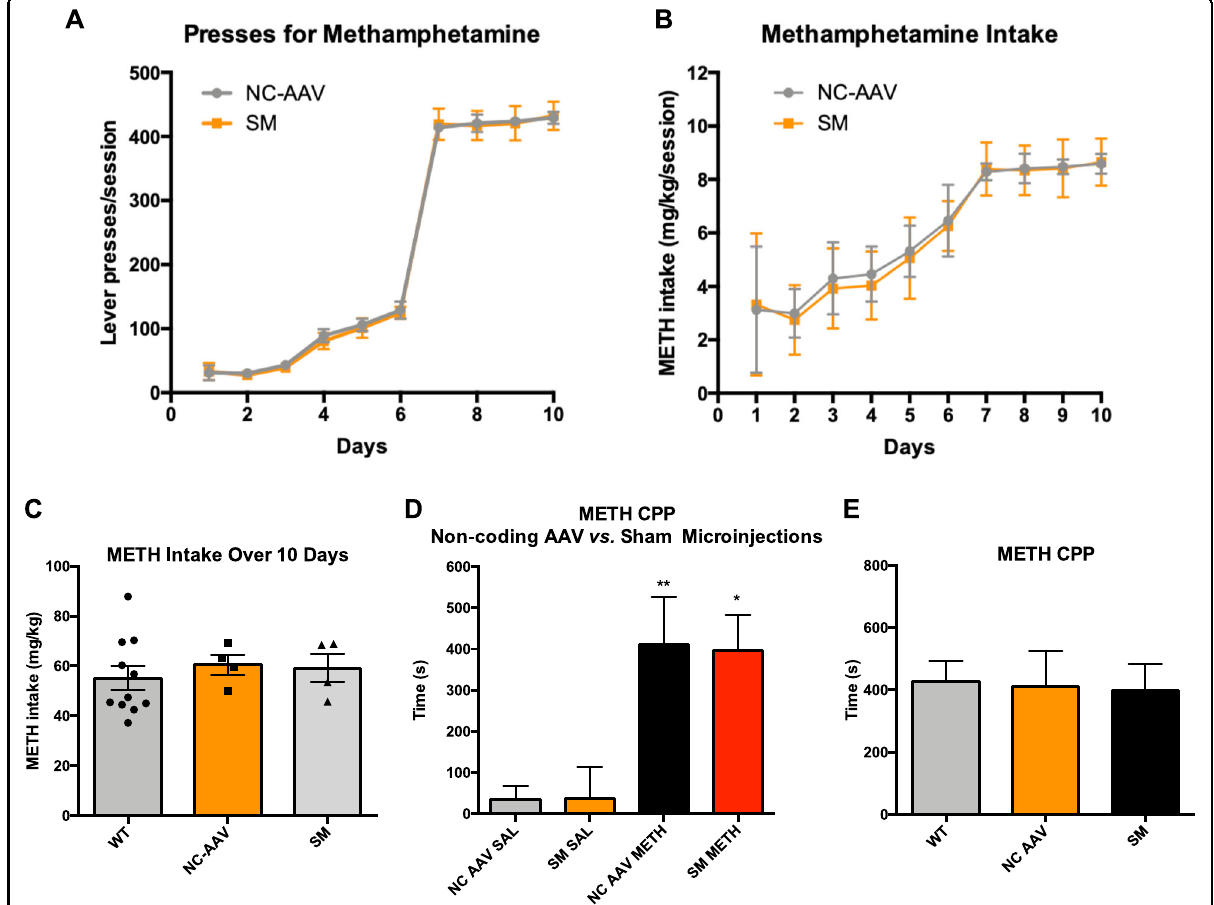
Fig. 2 Noncoding-AAV and Sham-microinjection control for behavioral experiments. Neither noncoding AAV2/6 (NC-AAV) nor sham microinjection (SM, microinjection of phosphate-buffered saline) had an effect on methamphetamine (METH) self-administration or preference for METH-paired compartment in the conditions place preference test in wild type (WT) rats. A Lever presses in NC-AAV and SM group. B METH intake in NC-AAV and SM group. C Conditioned place preference test results for NC-AAV and SM group. D METH intake in WT vs. NC-AAV and SM rats. E Preference for METH-paired compartment in WT vs. NC-AAV and SM rats. Data are expressed as mean ± SEM, n = 4/group. Abbreviations: CPP conditioned place preference, NAc nucleus accumbens, L left, R